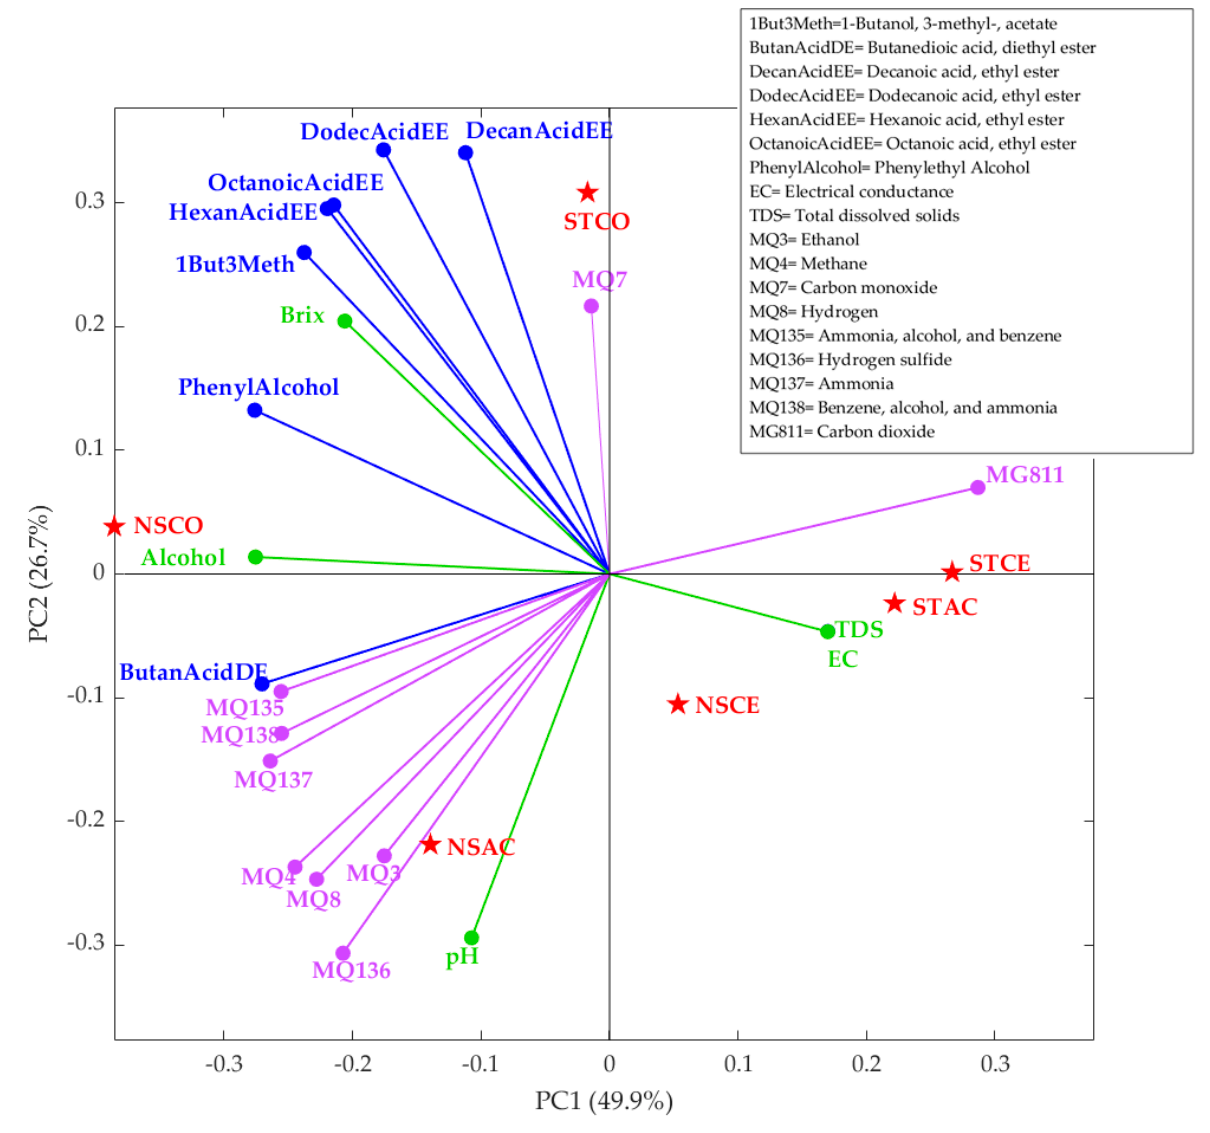
Figure 3. Principal component analysis showing the chemical measurements (blue), e-nose readings (purple) and volatile aromatic compounds (green). Abbreviations: NSAC = non-smoke-tainted wine with activated carbon treatment, NSCE = non-smoke-tainted wine with enzyme and activated carbon treatment, NSCO = control non-smoke-tainted wine, STAC = smoke-tainted wine with activated carbon treatment, STCE = smoke-tainted wine with enzyme and activated carbon treatment, STCO = control smoke ‐ tainted wine and PC = principal component. Red stars in the figure depict the samples. Figure 4 shows the significant correlations ( p < 0.05) between the chemical measure ‐ ments, volatile aroma compounds and e ‐ nose outputs. From the matrix, positive correla ‐ tions could be seen between 1 ‐ butanol, 3 ‐ methyl ‐ , acetate and octanoic acid, ethyl ester ( r = 0.9); hexanoic acid, ethyl ester ( r = 0.99); phenylethyl alcohol ( r = 0.93) and °Brix ( r = 0.82), as well as between butanedioic acid, diethyl ester and the alcohol content ( r = 0.82) and MQ135 gas sensor ( r = 0.90). Negative correlations could be observed between the MG811 gas sensor and butanedioic acid, diethyl ester ( r = − 0.82) and MQ4 ( r = − 0.90), MQ8 ( r = − 0.88), MQ135 ( r = − 0.88), MQ137 ( r = − 0.98) and MQ138 ( r = − 0.95) gas sensors.